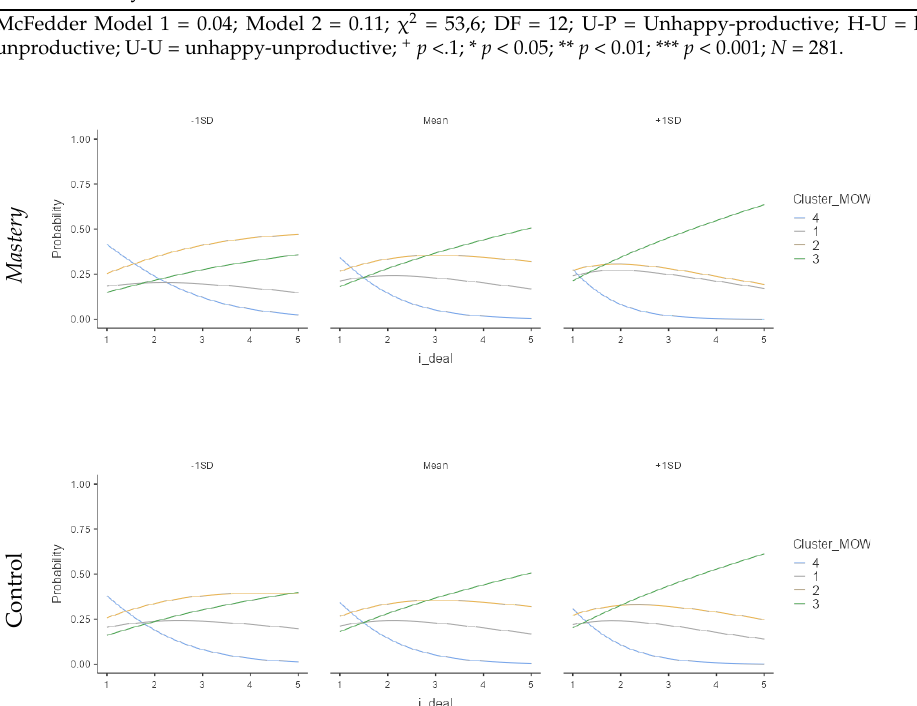
Figure 8. Recovery and Flexibility i-deal interaction related to Meaning of Work and Job Perfor- mance clusters. Cluster 1: happy-productive; Cluster 2: Unhappy-productive; Cluster 3: Unhappy- unproductive; Cluster 4: Happy-unproductive. (Study 1; N = 281).